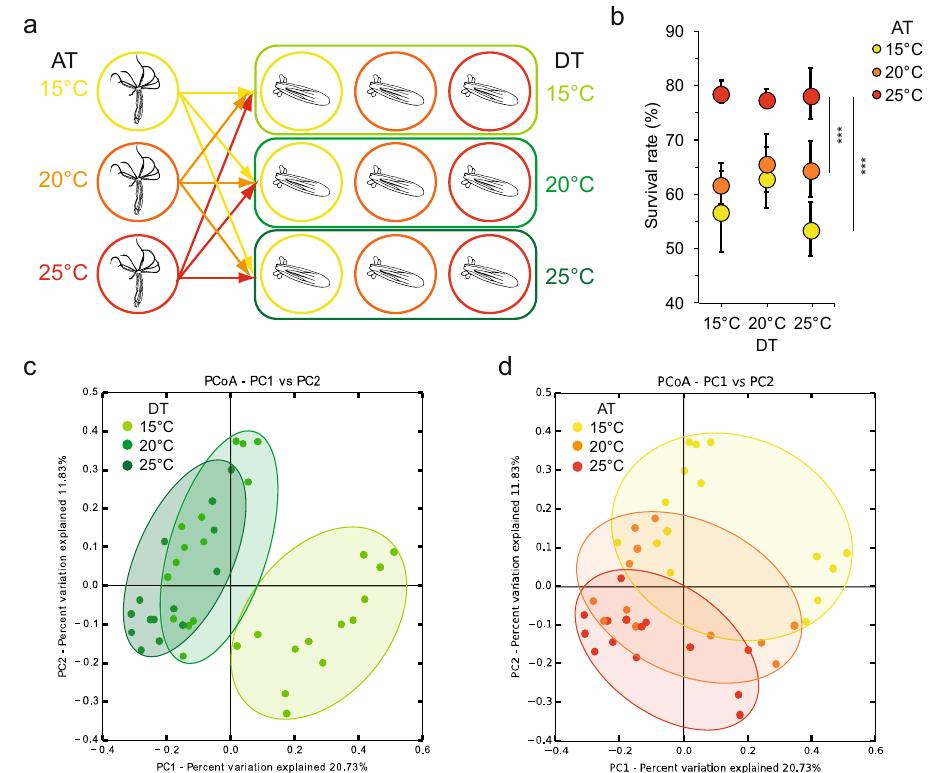
Fig. 6 Transmission of thermal tolerance to the offspring. a Experimental scheme: acclimated females from each AT were induced for sexual reproduction. All oocyte-packs were fertilized with the sperms from a single male polyp from the standard conditions. After fertilization, each embryo pack was split into 3 parts and placed at different DT (15, 20, or 25 °C). After 1 month of development, survival rate and bacterial colonization were analyzed. b Offspring survival rate (ratio between the initial number of oocytes and survived juvenile polyps were calculated), a Kruskal – Wallis test was performed followed by Dunn´s post hoc comparisons ( n = 10; H = 32.658; *** p < 0.001), average values with error bars indicating SE are presented. c PCoA (based on Binary-Pearson metric, sampling depth = 24,500) illustrating similarity of bacterial communities according with F1 DT. d PCoA (based on binary-Pearson metric, sampling depth = 24,500) illustrating similarity of bacterial communities according with F0 AT. Note: in c and d the same data are plotted, but with different color